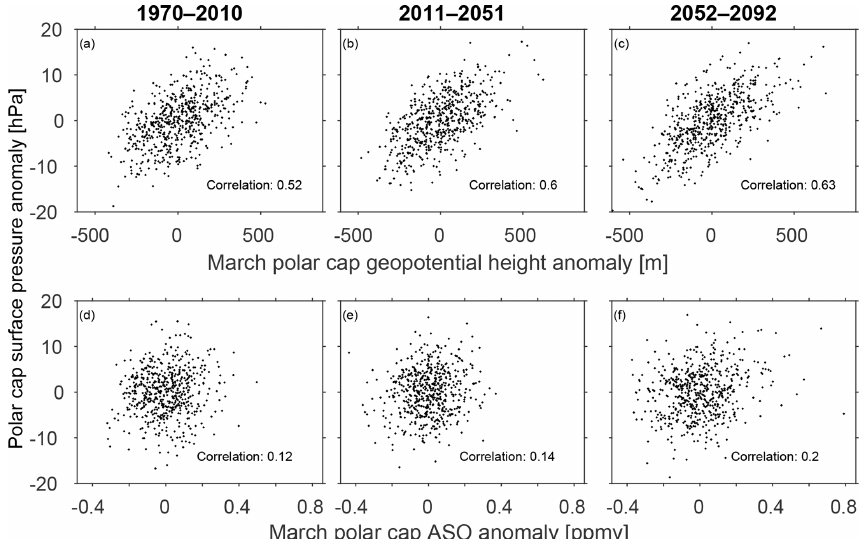
Figure 5. A scatter plot of ( y axis) polar cap surface pressure with March ( x axis; a, b, c ) polar cap geopotential height and ( x axis; d, e, f ) Arctic stratospheric ozone. March polar cap surface pressure is used for ( a, b, c ), and April polar cap surface pressure is used for ( d, e, f ), corresponding to the month with strongest coupling. Each year of each CCMI integration is marked with a diamond. All correlations are statistically significant at the 95% level as given by a two-tailed Student t test, as are the differences in correlation between ( a, b, c ) and ( d, e, f